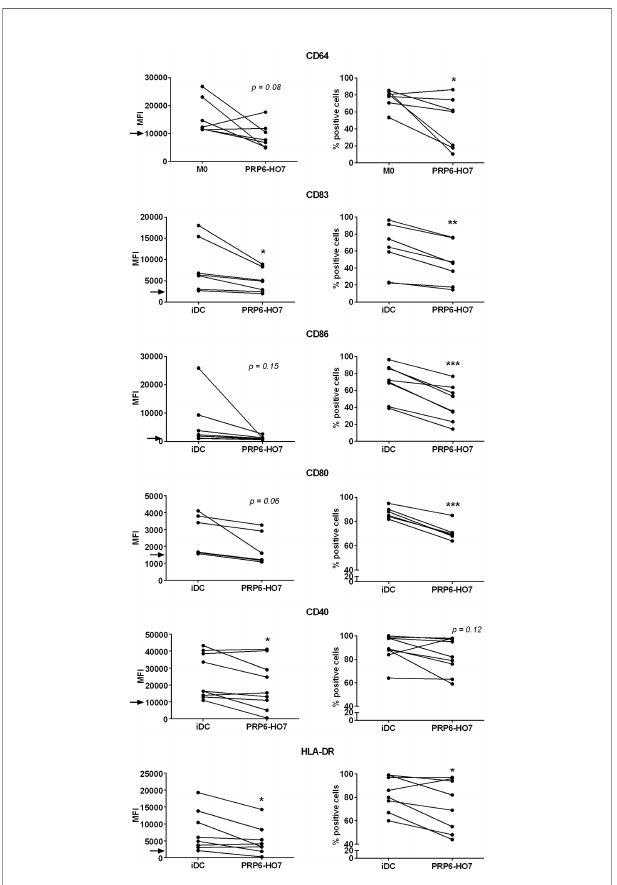
FIGURE 9 | PRP6-HO7 modulates intrinsically activated surface markers in differentiating Mo-DCs and Mo-macrophages from active autoimmune SLE patients. Human Mo-DCs and Mo-macrophages from active SLE patients (cohort 2) were either left untreated or incubated with PRP6-HO7 at 32 nM throughout their differentiation process. Cells were then collected, washed, and analyzed by fl ow cytometry for cell surface expression of the activation markers CD64 (M0), or CD83, the co-stimulatory molecules CD86, CD80 and CD40, and HLA-DR (iDC). MFI, Both the median fl uorescence intensity (MFI) and the percentage of positive cells for the different surface markers are indicated. The arrows indicate the MFI threshold of activity considered for each of the surface markers (CD64: 10000, CD83: 2500, CD86: 1000, CD80: 1500, CD40: 10000, HLA-DR: 2000). The results shown are the mean ± SD from 6-9 independent donors (*p < 0.05; **p < 0.01; ***p < 0.001 compared with M0 or